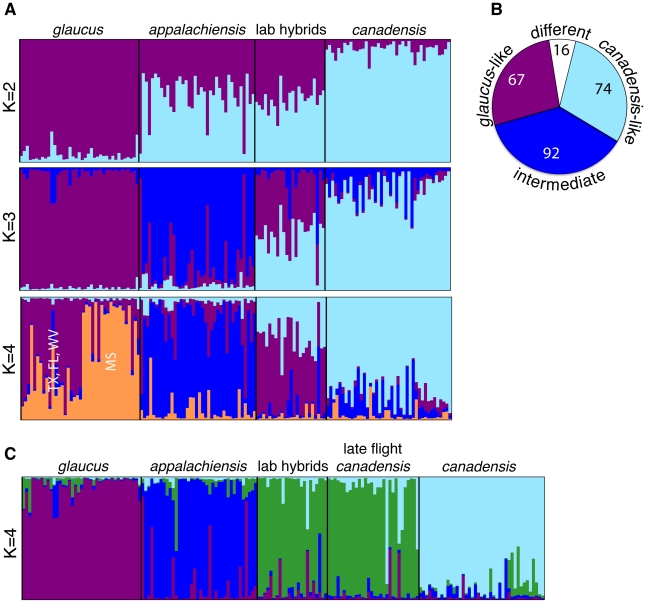
Genomic admixture in appalachiensis showing its hybrid origin and its contrast with laboratory-generated hybrids and late flight canadensis.(A) Population clustering of AFLP data in STRUCTURE under the assumption of two, three and four populations, comparing appalachiensis with laboratory-generated glaucus x canadensis hybrids. (B) appalachiensis AFLP allele frequencies with respect to glaucus and canadensis, based on species pair-wise locus-by-locus AMOVAs. Allele frequencies of “glaucus-like” AFLPs were significantly different from canadensis, “canadensis-like” AFLPs were significantly different from glaucus, “intermediate” were intermediate between glaucus and canadensis but significantly different from neither, and “different” were significantly different from both glaucus and canadensis. (C) Population clustering in STRUCTURE under the assumption of four populations, showing genomic similarity between the laboratory-generated hybrids and late flight canadensis, and distinctiveness of appalachiensis (also see Figure S2). For (A) and (C), admixture proportions of the sampled individuals, rather than their assignment probabilities, are shown.